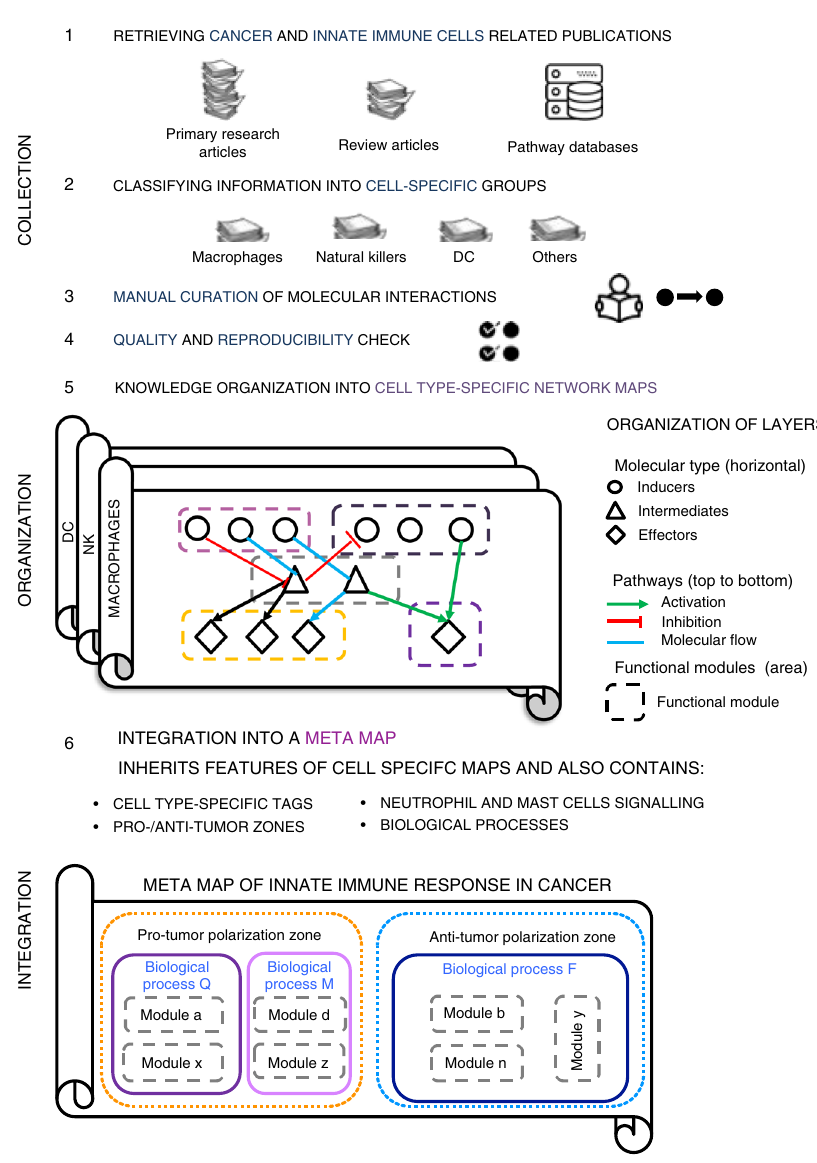
Fig. 1 Map construction work fl ow and map structure. The scheme demonstrates the steps of meta-map construction starting from collection of cancer- speci fi c and innate-immune speci fi c information about individual molecular interactions from scienti fi c publications and databases, manual annotation and curation of this information (steps 1 – 4), then organization of this formalized knowledge in form of cell-type speci fi c maps (step 5), and fi nally integration the cell-type speci fi c networks in one global meta-map of innate immune response in cancer with areas corresponding to biological processes, modules, pro- and anti-tumor polarization (step